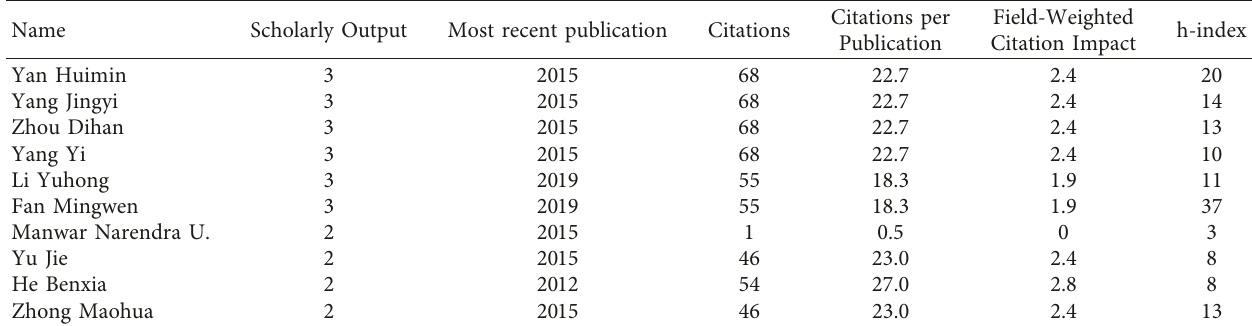
Table 2: Top 10 authors of scientific output in Scopus of all publication types about caries vaccine.